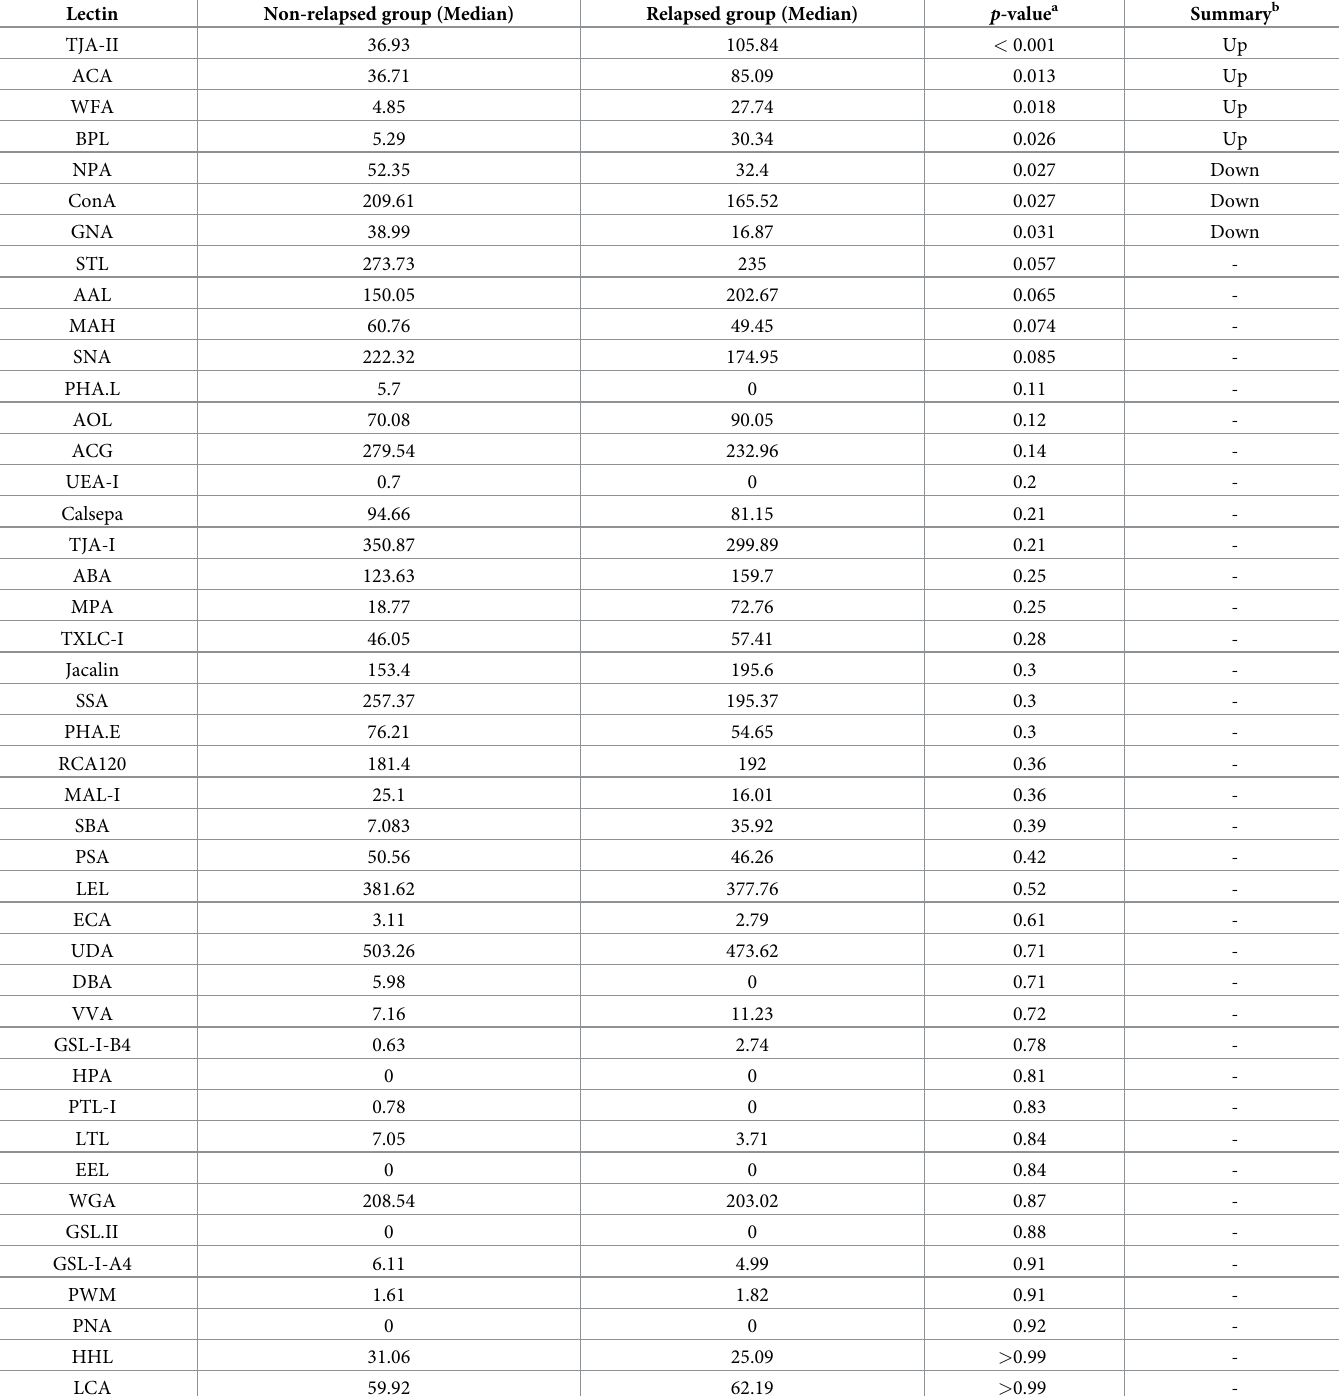
Table 2. Comparison of the mean fluorescence intensity of 45 lectins between non-relapsed ( n = 25) and relapsed ( n = 5) triple-negative breast cancer (TNBC)